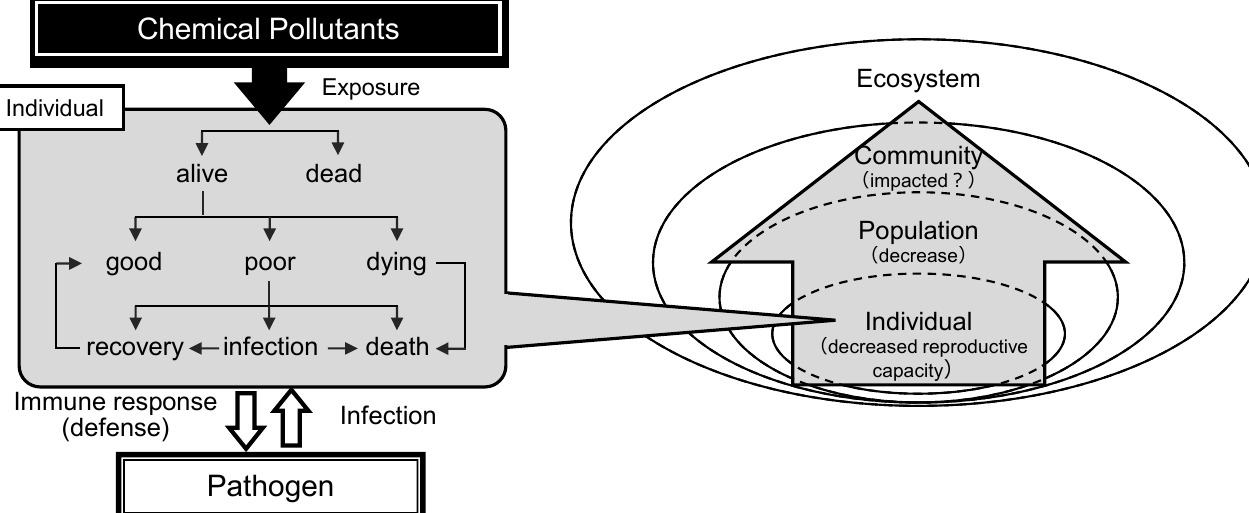
Figure 1. Immunotoxicological effects and ecological risks of chemical pollutants. An individual organism exposed to chemical pollutants will be either alive or dead ( left panel ). Even if the organism is alive, its health will be altered as a function of the degree of exposure (chemical concentration and/or exposure time). Poor health means decreased immune function due to exposure to chemical pollutants and increases the risk of infection by pathogens. If organisms do not recover from damages caused by chemical pollutants, such exposure will consequently cause an increase of death rates and a decrease of the population ( right panel ). The impact may extend from the population to the community and then lead to an alteration of the ecosystem.